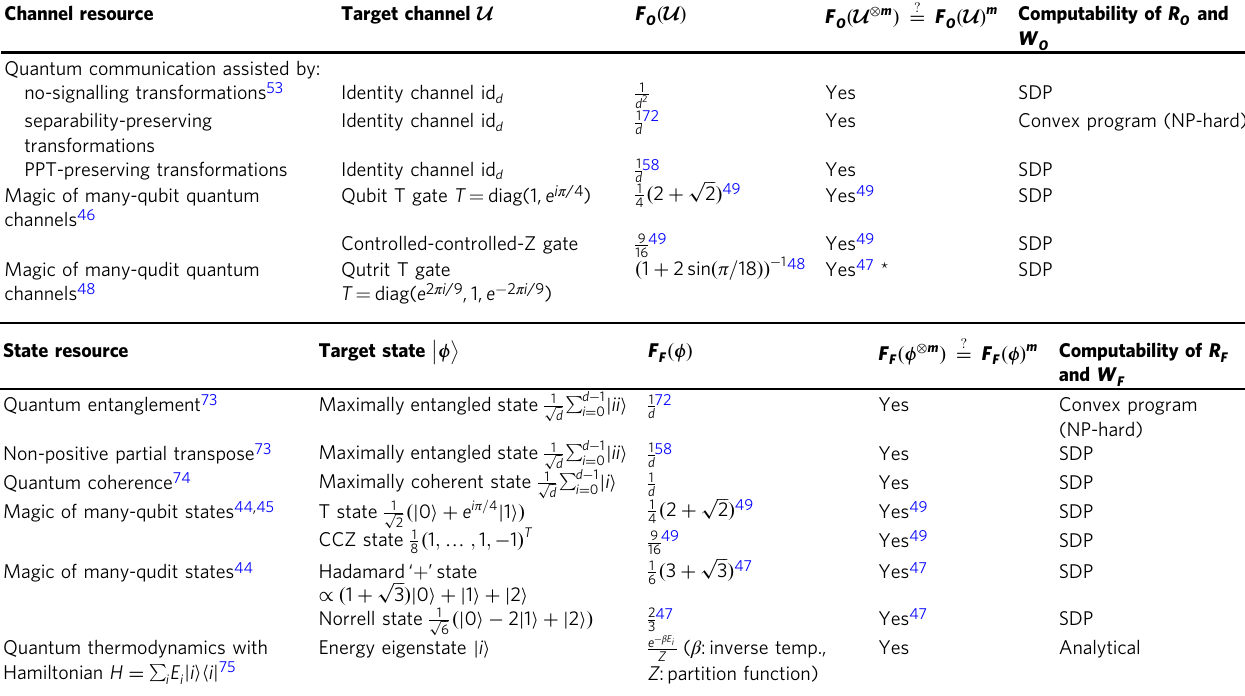
Table 1 Applicability of our bounds to common quantum